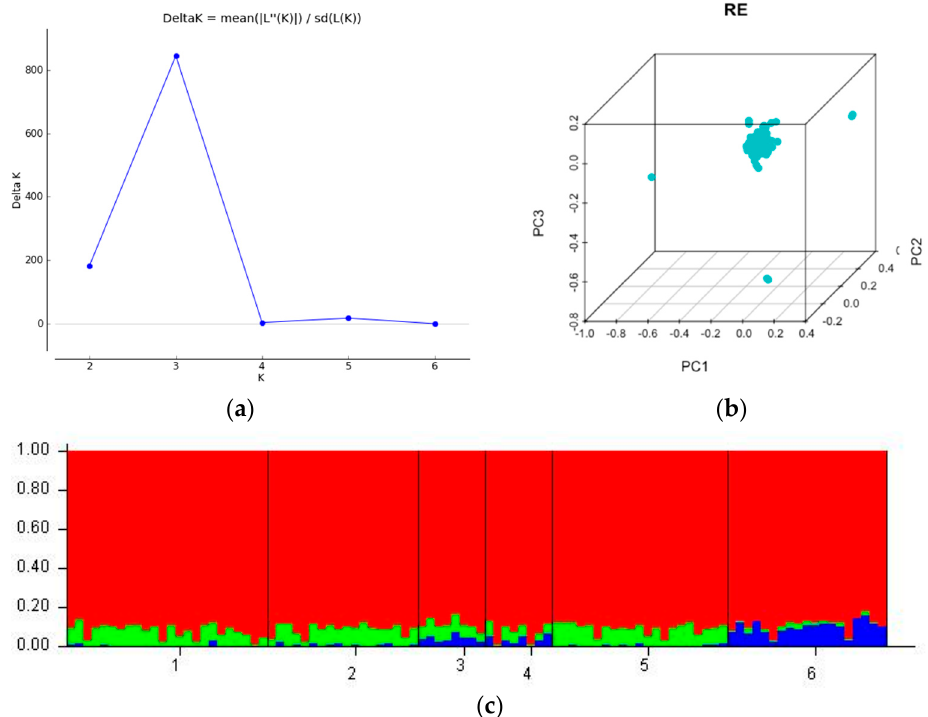
Figure 4. ( a ) Relationship between delta K and K obtained through Structure Harvester, ( b ) principal component analysis on 98 accessions of Rhanterium, ( c ) Bayesian model clustering, numbers 1-6 represent the six populations, and the colors depict three clusters.